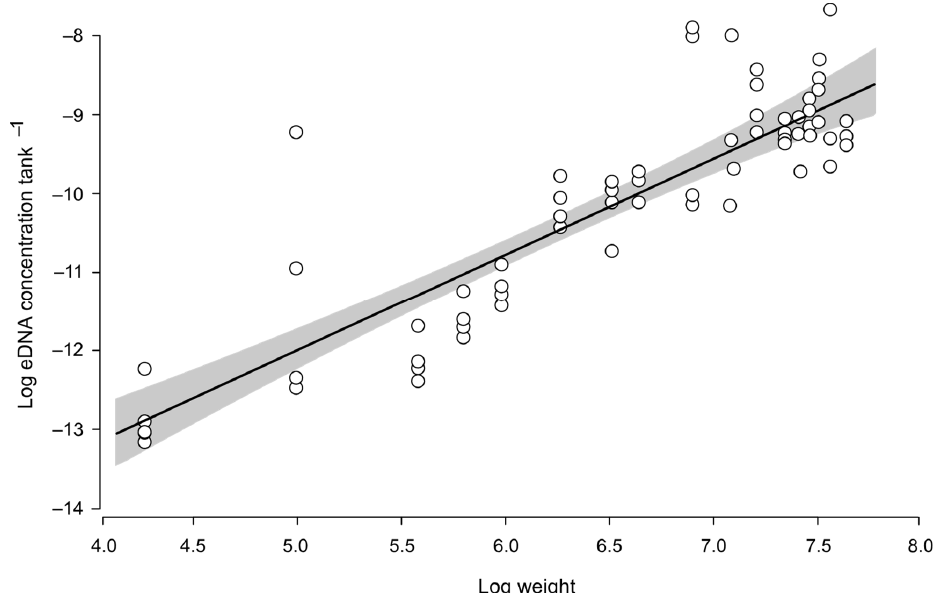
Figure 3. Relationship between log eDNA concentration tank –1 and log weight of mulloway, Argy ‐ rosomus japonicus assessed during experiment 3 completed at the Port Stephens Fisheries Institute, New South Wales, Australia during August, 2021. Open circles are the raw data, whereas the solid and dashed lines indicate the linear model fit and 95% confidence intervals, respectively.